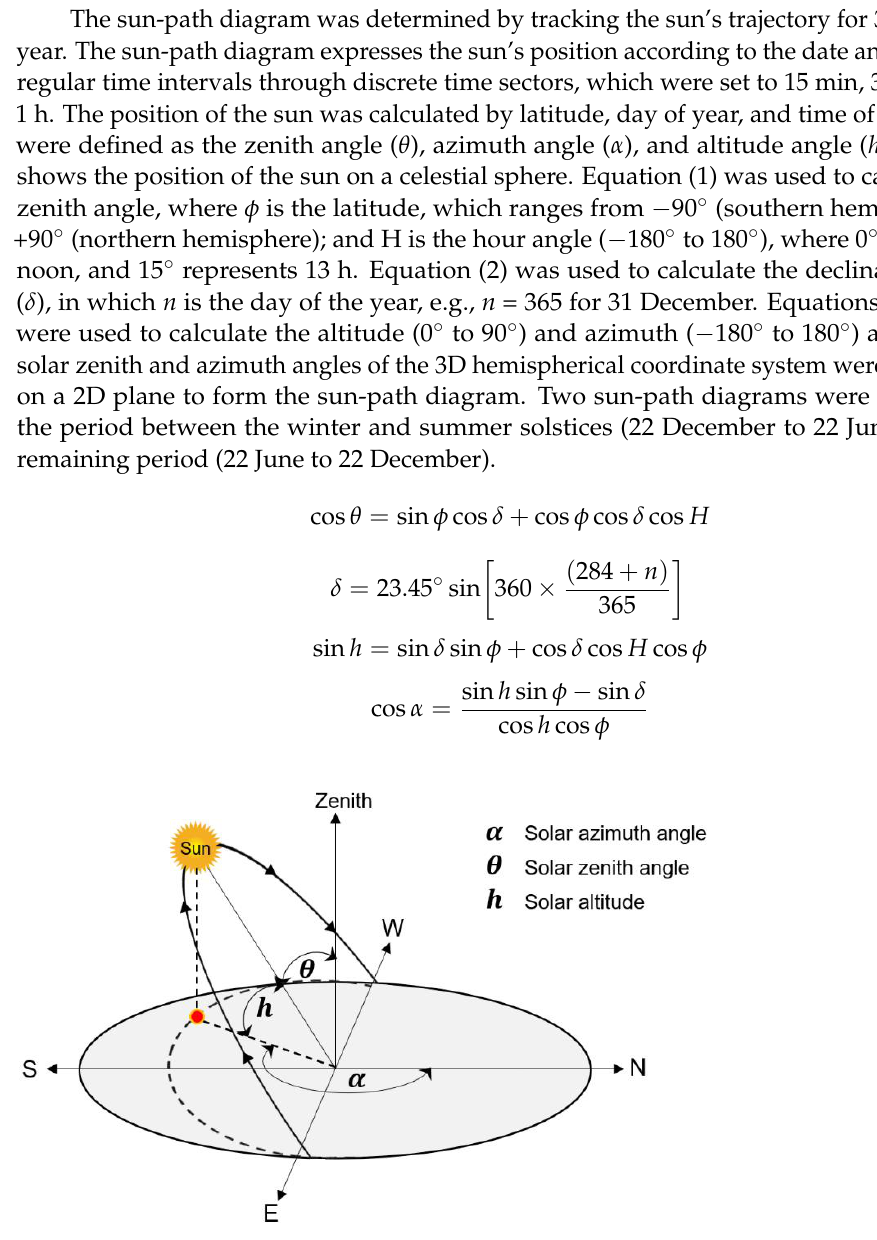
Figure 4. Solar position defined by the solar azimuth angle ( 𝛼 ), solar zenith angle ( 𝜃 ), and altitude ( ℎ